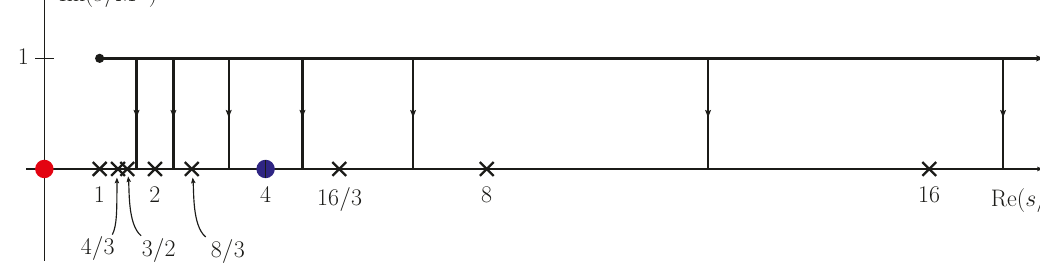
Figure 2 . Contours for the numerical solution of the di(cid:11)erential equations for the master integrals. The points on the abscissa correspond to singularities of the di(cid:11)erential equations. Every time a contour reaches the real axis, the interval between singularities is explored in both